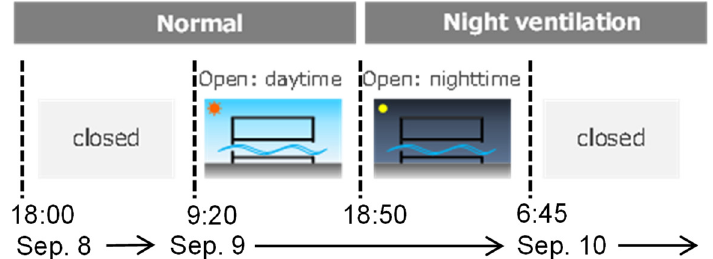
Figure 8. Procedure of measurements and opening/closing of doors.